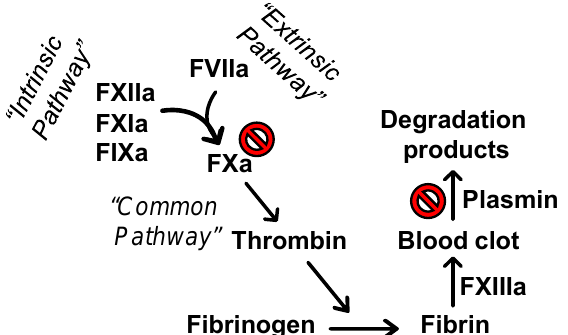
Figure 5. Representation of the coagulation (clot formation) and fibrinolysis (clot lysis) processes. The coagulation proceeds extrinsically (FVIIa) and / or intrinsically (FXIIa, FXIa, and FIXa). The two pathways further promote coagulation through the common coagulation pathway involving thrombin and FXa. Thrombin activates fibrinogen to fibrin which gets cross-linked by the action of FXIIIa. The resulting insoluble mesh of fibrin entraps activated platelets as well as red blood cells to form the blood clot. Following the clot formation, the clot undergoes plasmin-mediated lysis. The in vitro e ff ect of pentamidine isethionate on coagulation and fibrinolysis is, in part, due to its inhibitory e ff ects on FXa and plasmin, respectively.